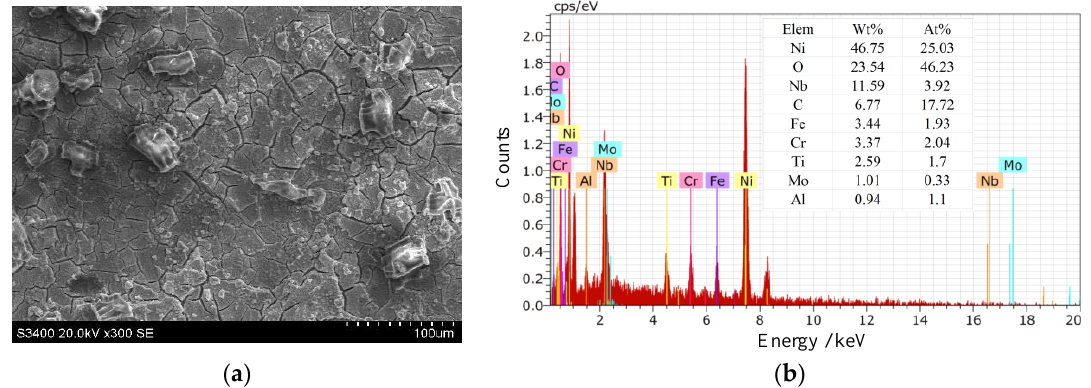
Figure 4. Scanning electron microscopy (SEM) and energy-dispersive X-ray spectroscopy (EDX) results for the corroded specimen in 106 g/L NaNO 3 solution. ( a ) SEM image of the specimen surface; ( b ) EDX of machining products.